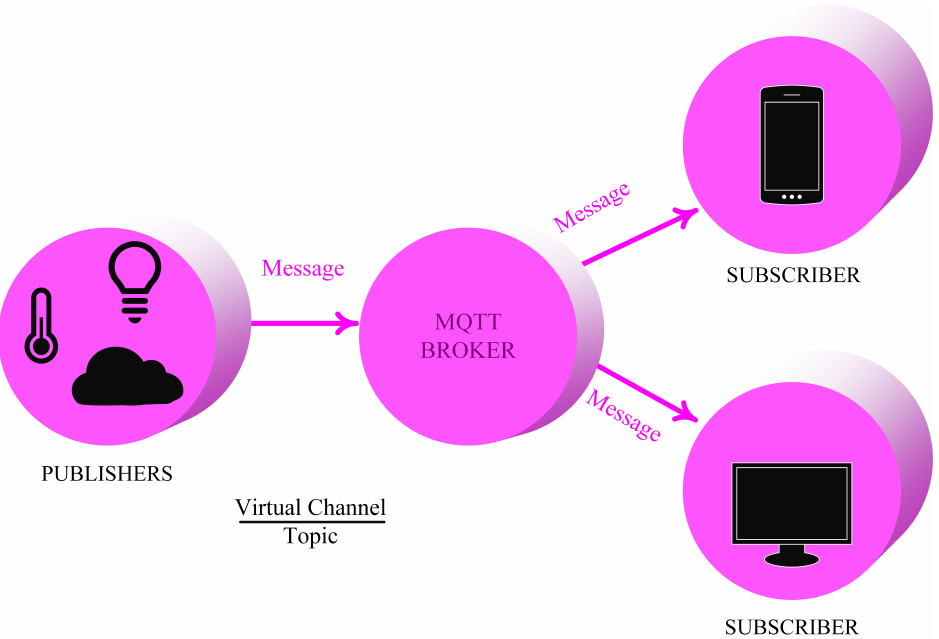
Figure 9. Schematic of the process involved in the MQTT protocol: publishers deliver the data to the broker and then the subscribers make a request to the broker for the desired